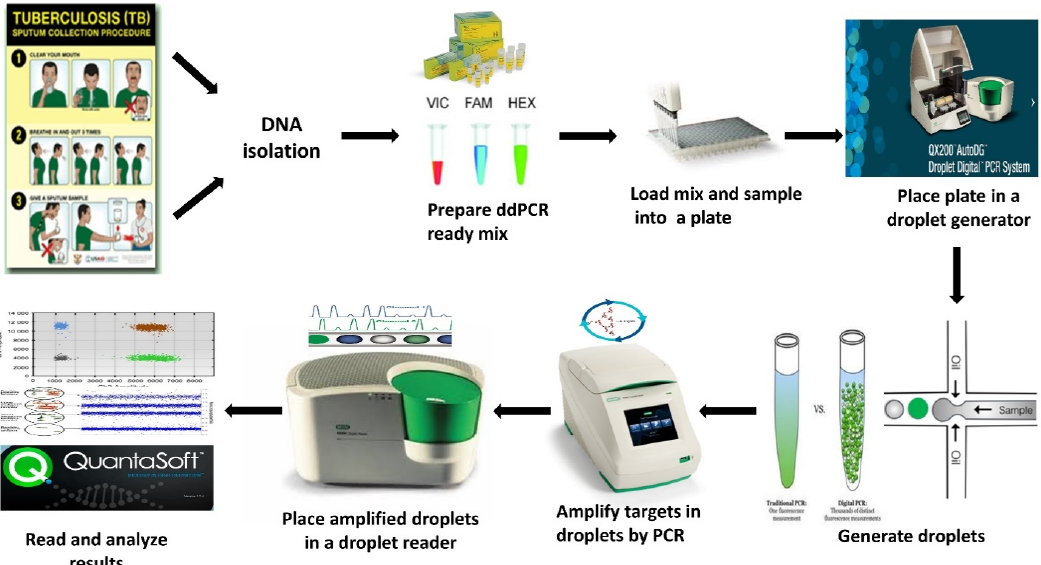
Figure 1. Overview of the droplet digital PCR (ddPCR) assay workflow for tuberculosis (TB) detection.